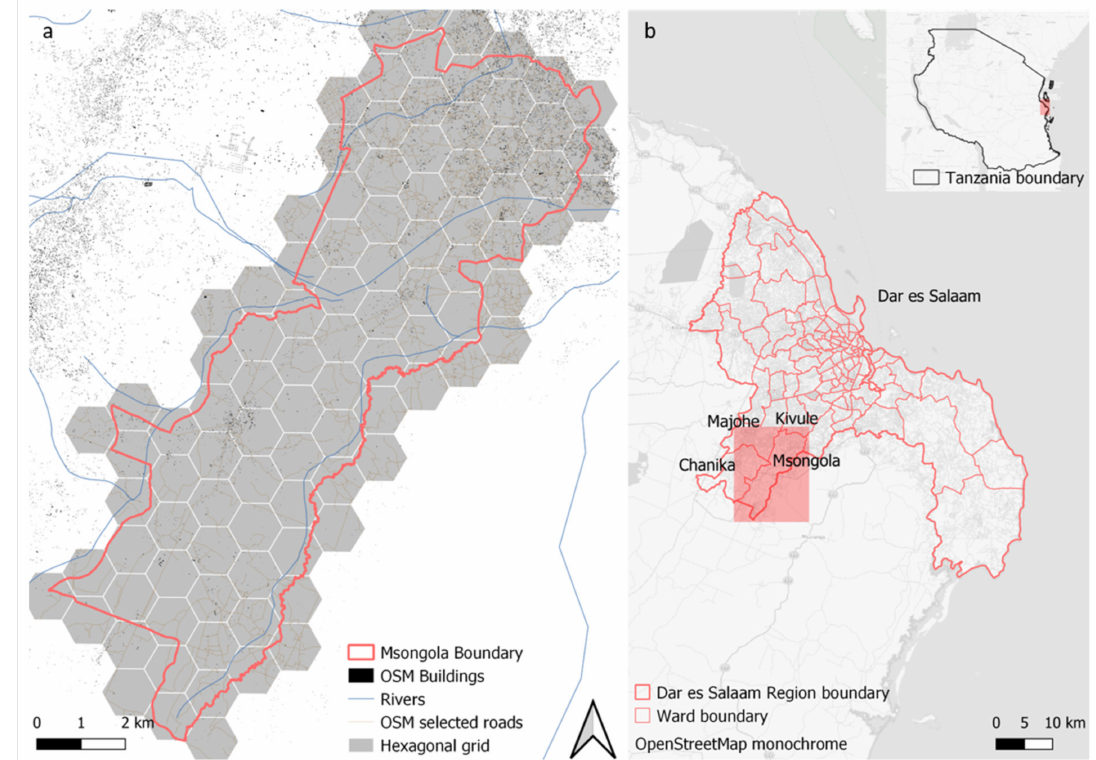
Figure 1. Study region of Dar es Salaam with ( a ) Msongola ward details with data including rivers, roads, and buildings and hexagonal grid overlay and ( b ) Location of Msongola ward in the city of Dar es